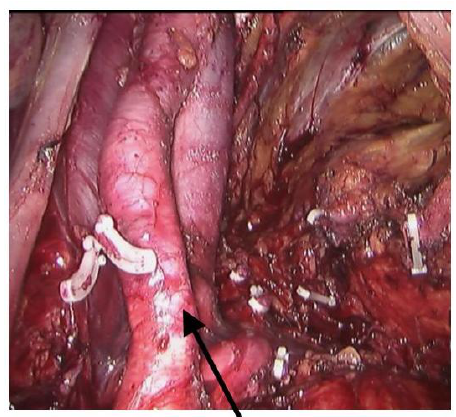
FIGURE 2. External iliac vessels.